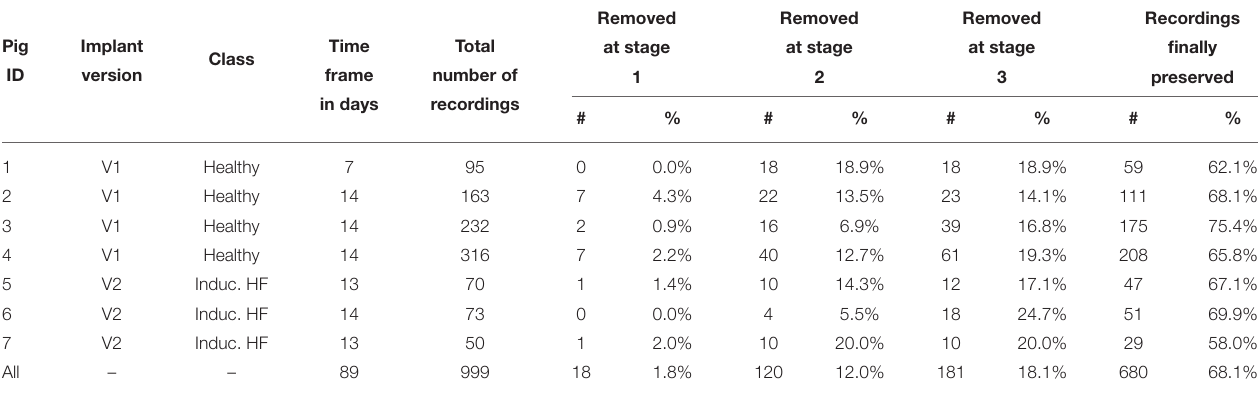
TABLE 3 | Description of the data acquired for phase 2 and summary of the signal quality results.